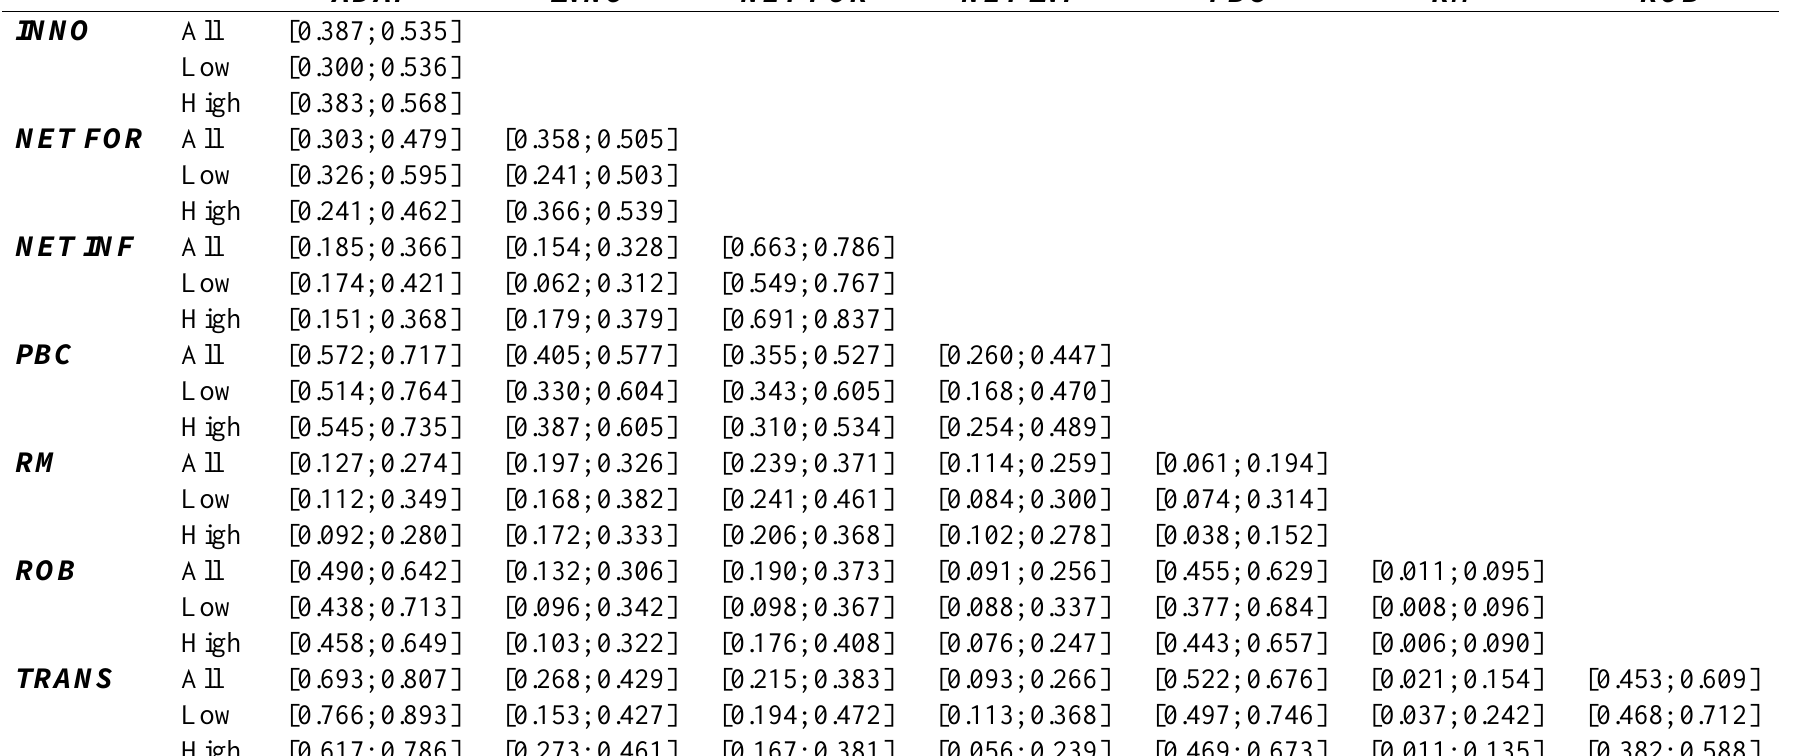
ADAP INNO NET FOR NET INF PBC RM ROB